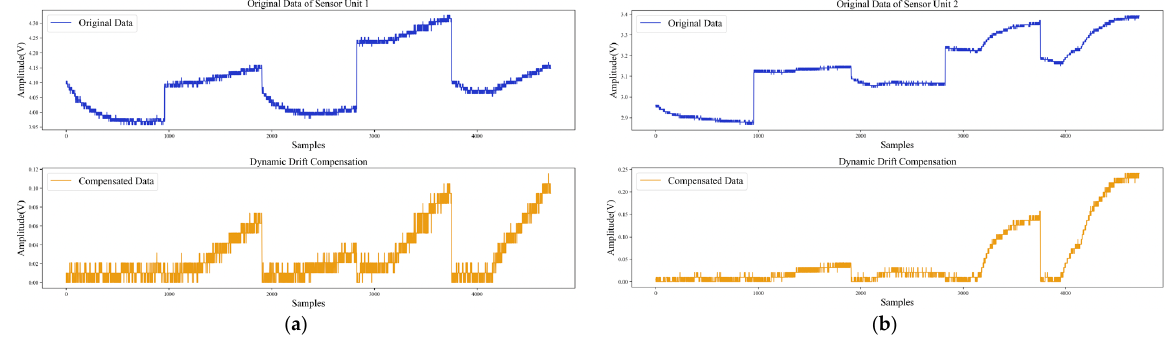
Figure 17. Simple baseline processing: ( a ) Drift compensation for sensor unit 1; ( b ) Drift compensa- tion for sensor unit 2.